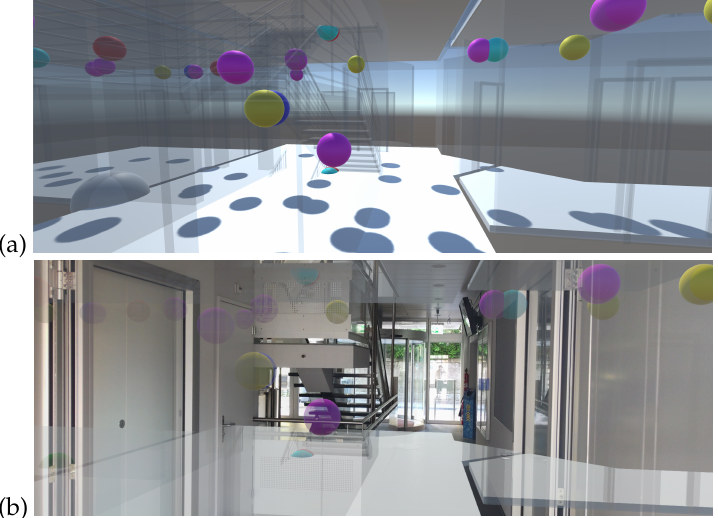
Figure 1. Comparison of a Digital Twin and Fused Twins. In both rows, the same lobby of a building is shown. ( a ) the DT of a sensor system with 390 nodes is visualised in Virtual Reality (VR) [20,21]. The white areas visualise the areas of observation and the coloured spheres encode the type of sensor that is located at the respective position in the building. ( b ) The FTs [17] are visualised in Mixed Reality (MR) [22] by embedding the DT in situ in its PT, thus fusing the two. The fused representation enables Situated Analytics [19] which facilitates the user’s understanding of analysis through spatial cues of the